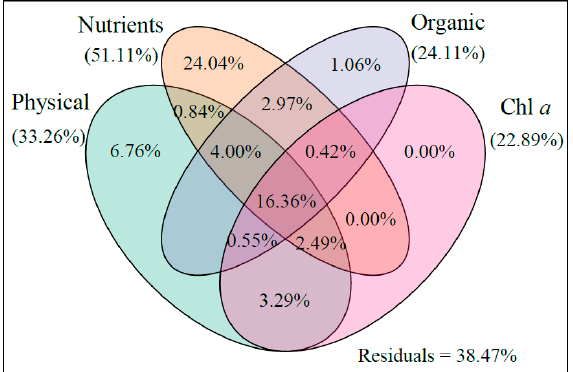
Figure 11. The influence of physical parameters, nutrients, organic matter, and Chl a features on the bacterial community structure estimated via VPA. Physical parameters included T, S, pH, TUR, and DO; nutrients included TAN, NO 3 − , NO 2 − , PO 43 − , and SiO 32 − ; and organic matter included TN and TP. The percentages represent the variance explained. The values < 0 are not shown.